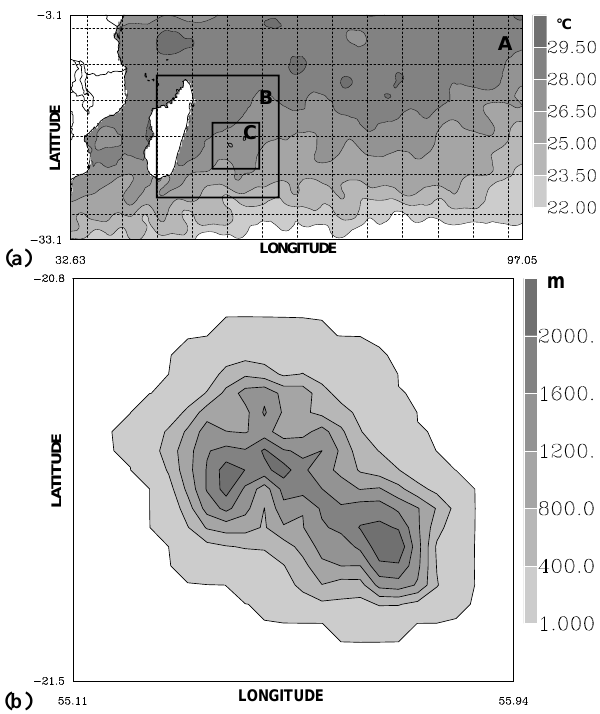
Fig. 3. (a) Configuration of the three nested domains and sea surface temperature (shaded, ◦ C) on 22 January 2002. Domain A has 200 × 100 grid points with 36km grid resolution, domain B has 162 × 162 grid points with 12km grid resolution, and domain C has 180 × 180 grid points with 4km grid resolution; (b) Orography of R´eunion island in domain C